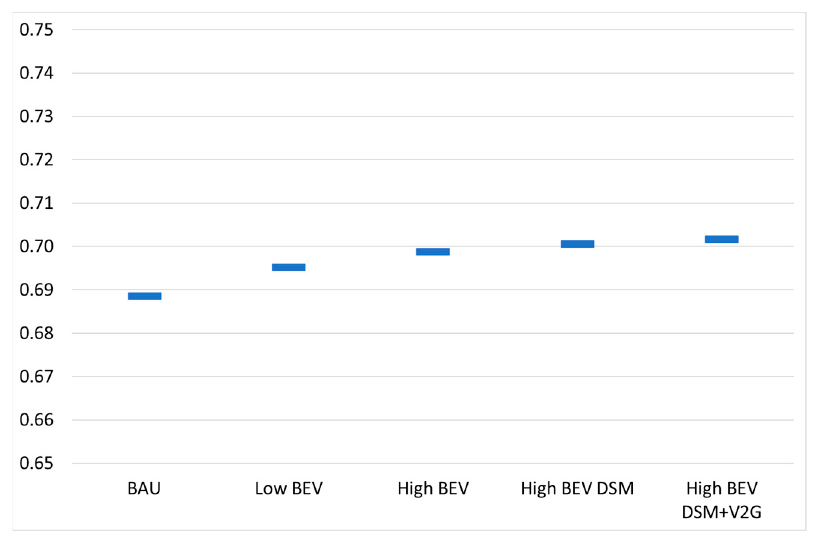
Figure 8. Life-cycle primary-to-electric energy conversion efficiency of the domestic grid mix ( η G ).